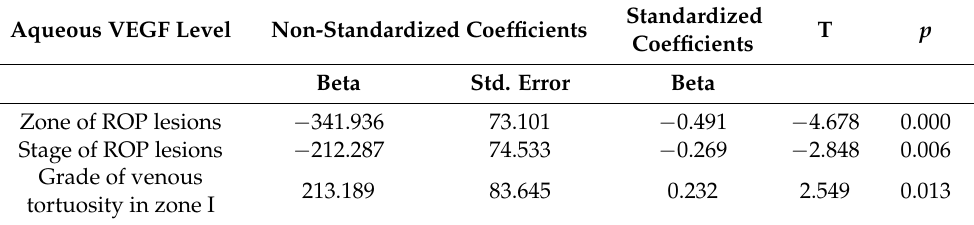
Table 2. Multiple linear regression analysis results of the variables affecting the aqueous VEGF